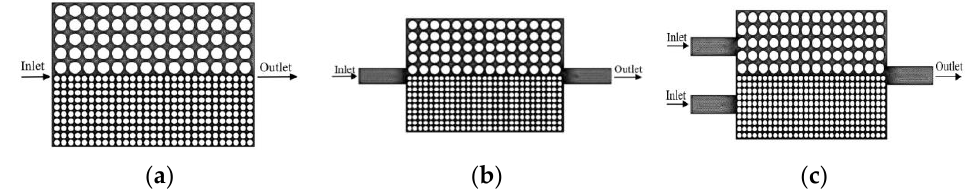
Figure 1. ( a ) Full perforation and commingling production micro-model. ( b ) Partial perforation and commingling production-injection micro-model. ( c ) Separated layer injection and commingling production micro-model.